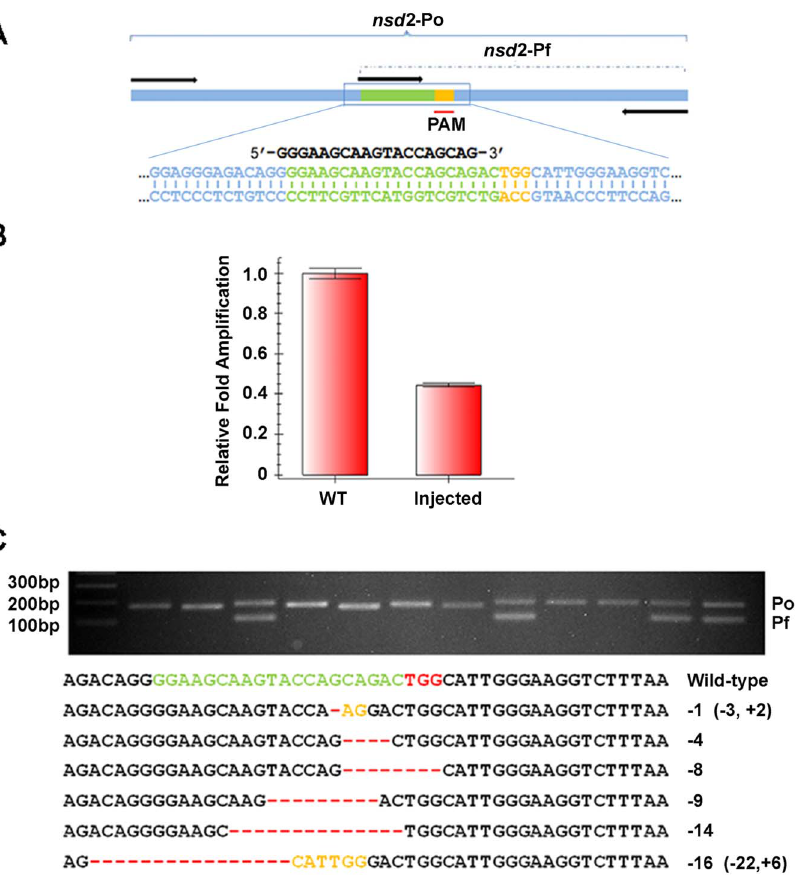
Figure 4. Identification of mutations induced by nsd2 Cas9. (A) A schematic diagram showing primers for detecting mutations in Cas9 target site of nsd2 gene. (B) The relative amplification efficiency of nsd2 Pf primers to Po primers. nsd2 Cas9 mRNA injection dramatically reduced the amplification efficiency of nsd2 Pf primers. 5 embryos from the wild-type or the nsd2 -Cas9-injected group were pooled and analyzed by qPCR, and 3 pools of each group were analyzed in an independent experiment. Similar results were obtained in three independent experiments. (C) Identification of a mutation in a single allele with T-CIA. Upper panel was an agarose electrophoresis result of PCR products amplified with nsd2 Po and Pf primers. Lower panel listed the sequences of mutant colonies identified in upper panel.